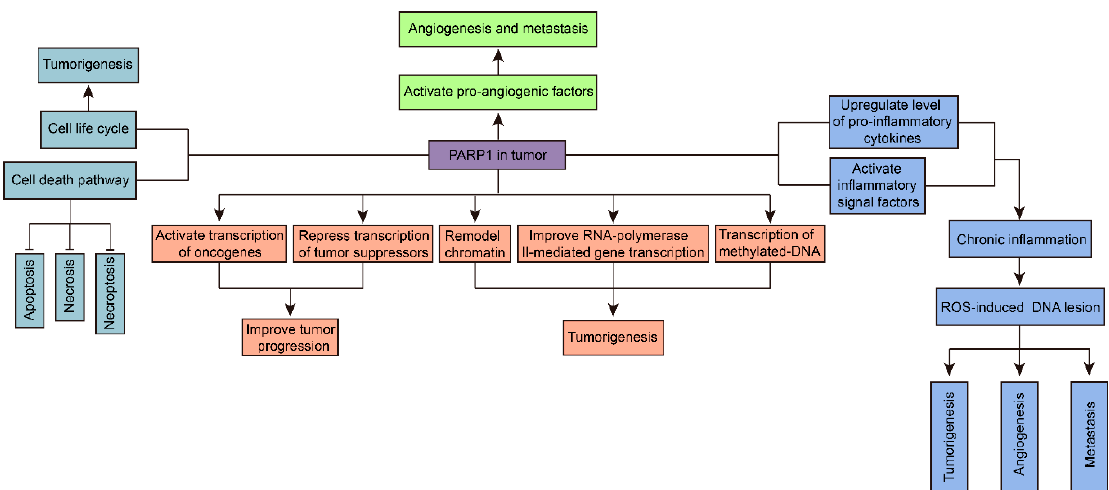
Figure 3. The multifunction of PARP1 in tumorigenesis. PARP1 is considered to promote tumor development potentially through many pathways. Briefly, PARP1 regulates gene transcription through interacting with transcription factors, transcription machinery, and chromatin modulators. Hyperactivated PARP1 upregulates inflammatory signal factors in tumors. Also, PARP1 modulates cancer cellular life cycle via regulating cellular mitosis and cell death pathways, including apoptosis, necrosis, and necroptosis. PARP1 activates pro-angiogenic factors and induces angiogenesis and metastasis in tumors.